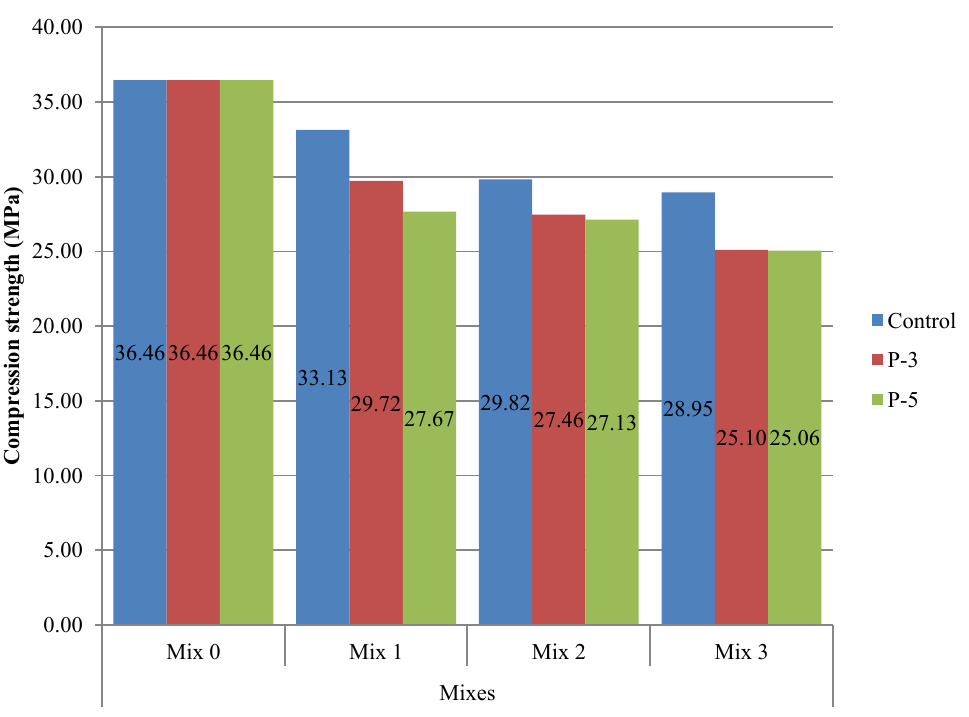
Figure 6. Compressive strength test